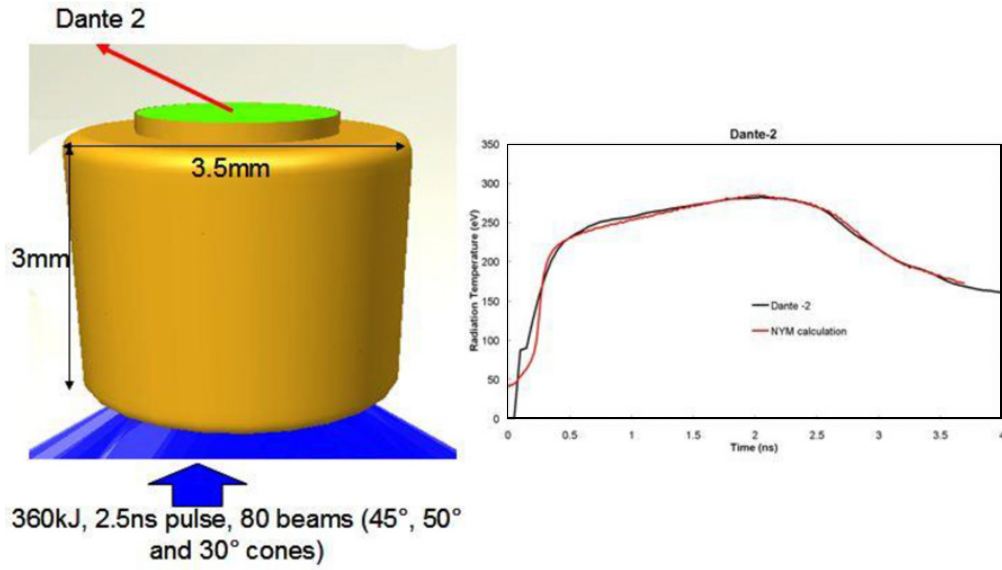
Figure 2. Hohlraum